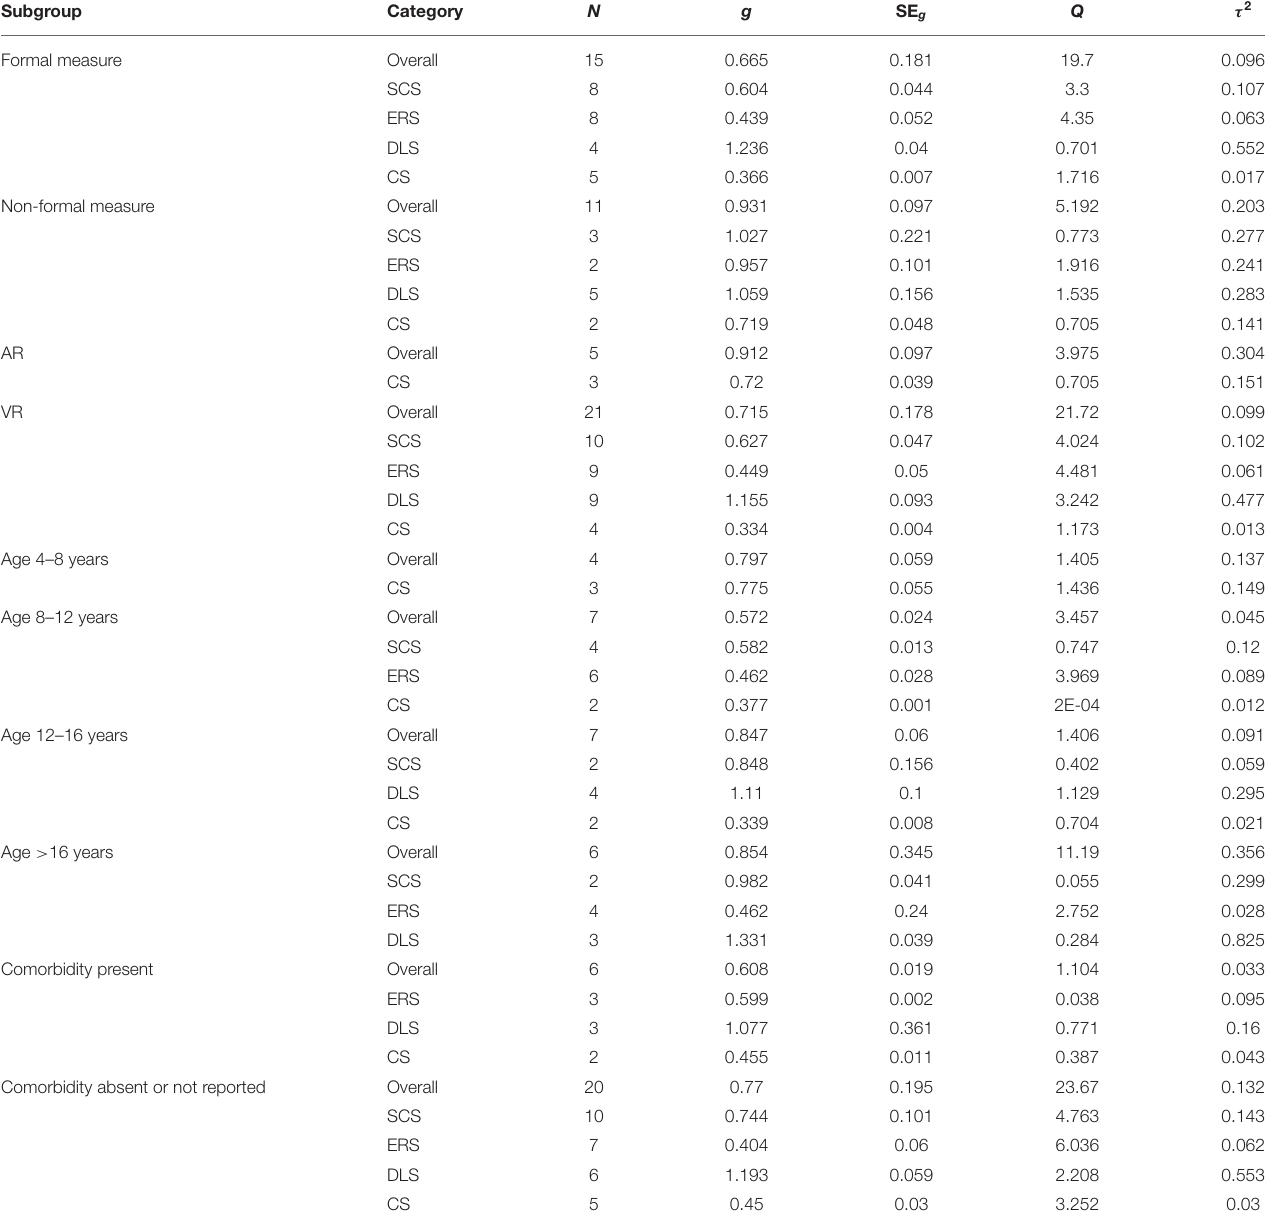
TABLE 3 | Subgroup meta-analysis results for type of measure, type of technology, and age moderators. Subgroup